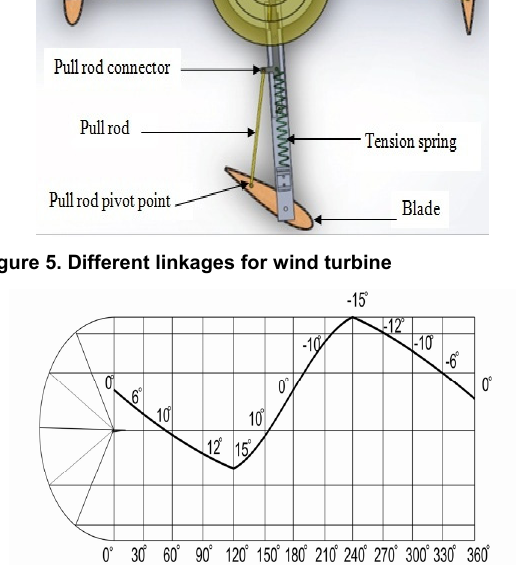
Figure 6. Cam design displacement diagram